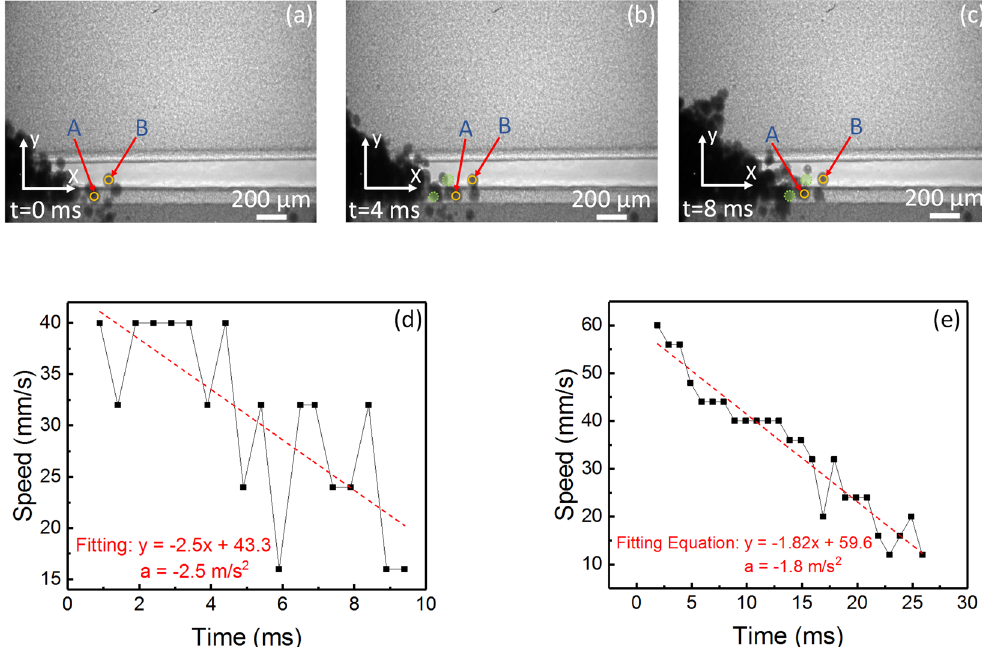
are − 2.5 m/s 2 and − 1.8 m/s 2 ,